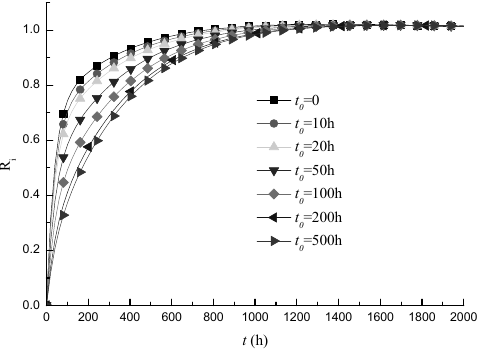
Figure 20. Relationship between grout setting time and rate of stress recovery.